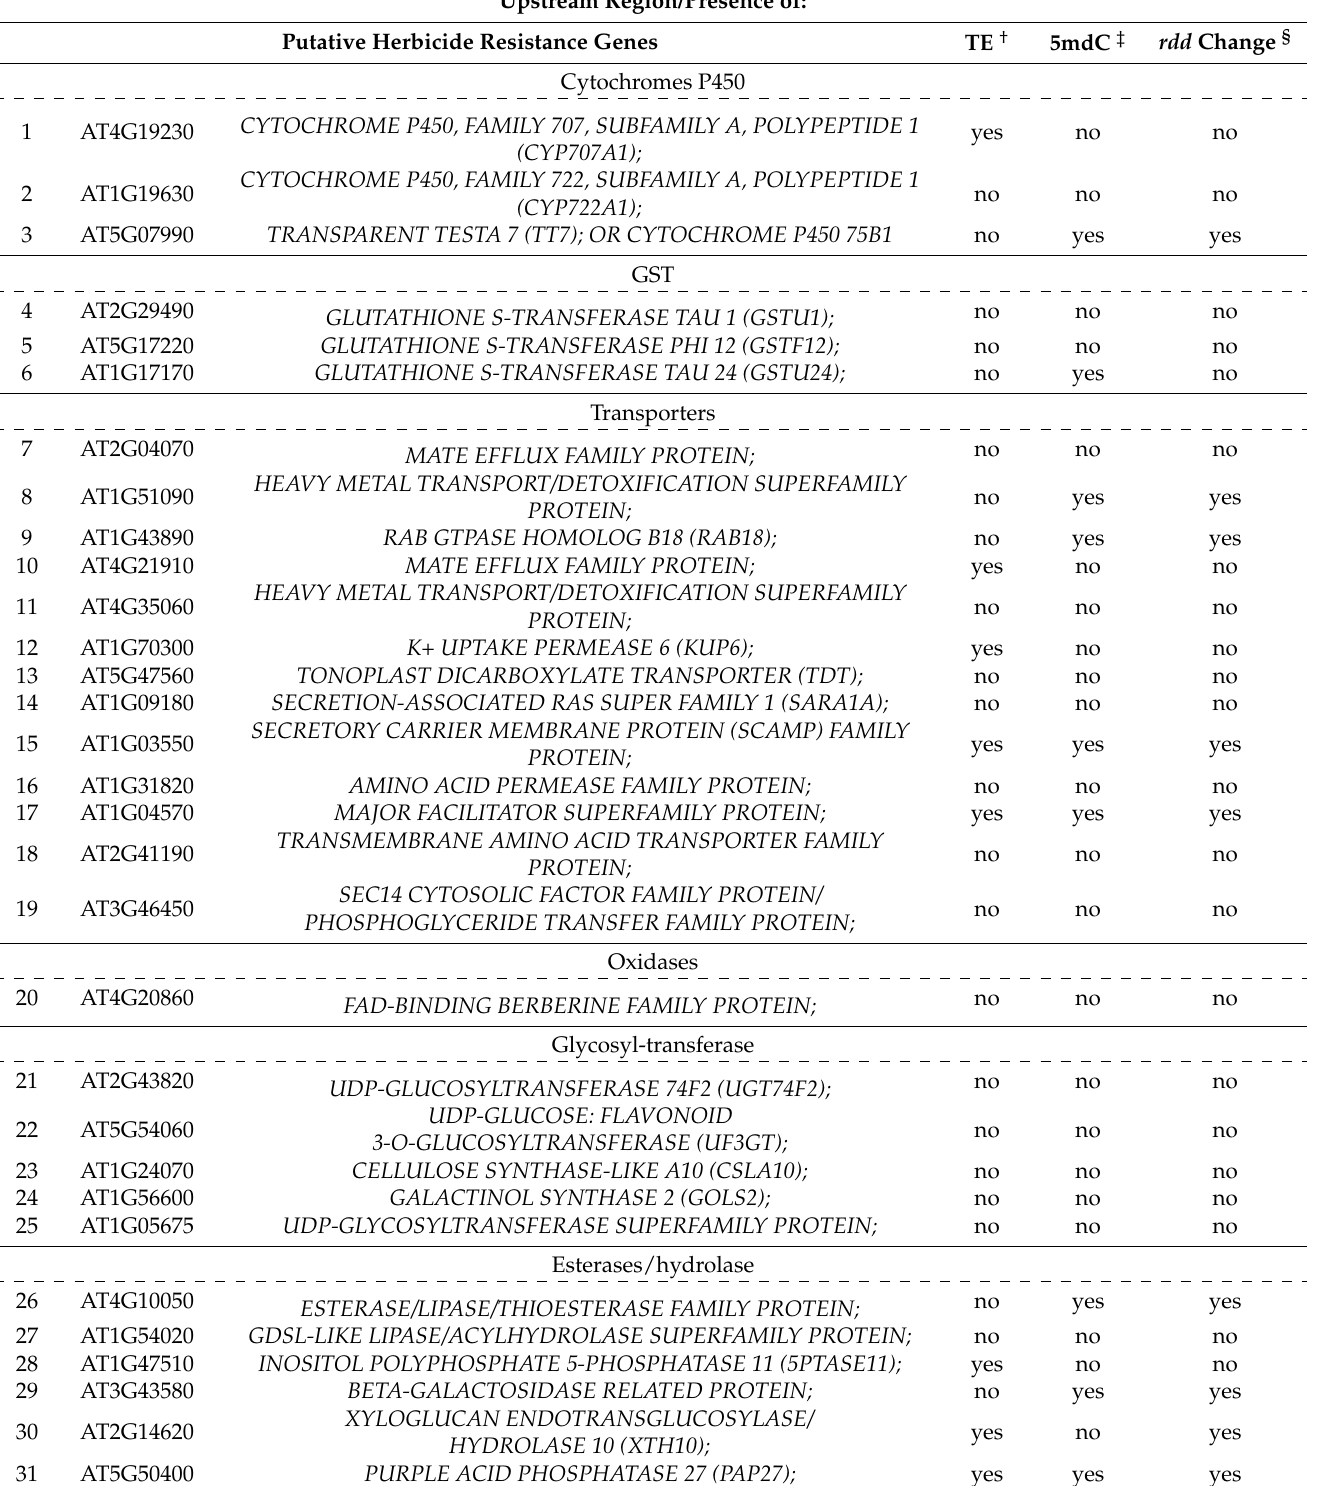
Table 1. In silico analysis of ≈ 1 kb region upstream of the transcription start site of putative herbicide resistance genes (based on the DNA methylation browser by Jacobsen lab, UCLA; http://genomes.mcdb.ucla.edu/AthBSseq/, accessed on 8 January